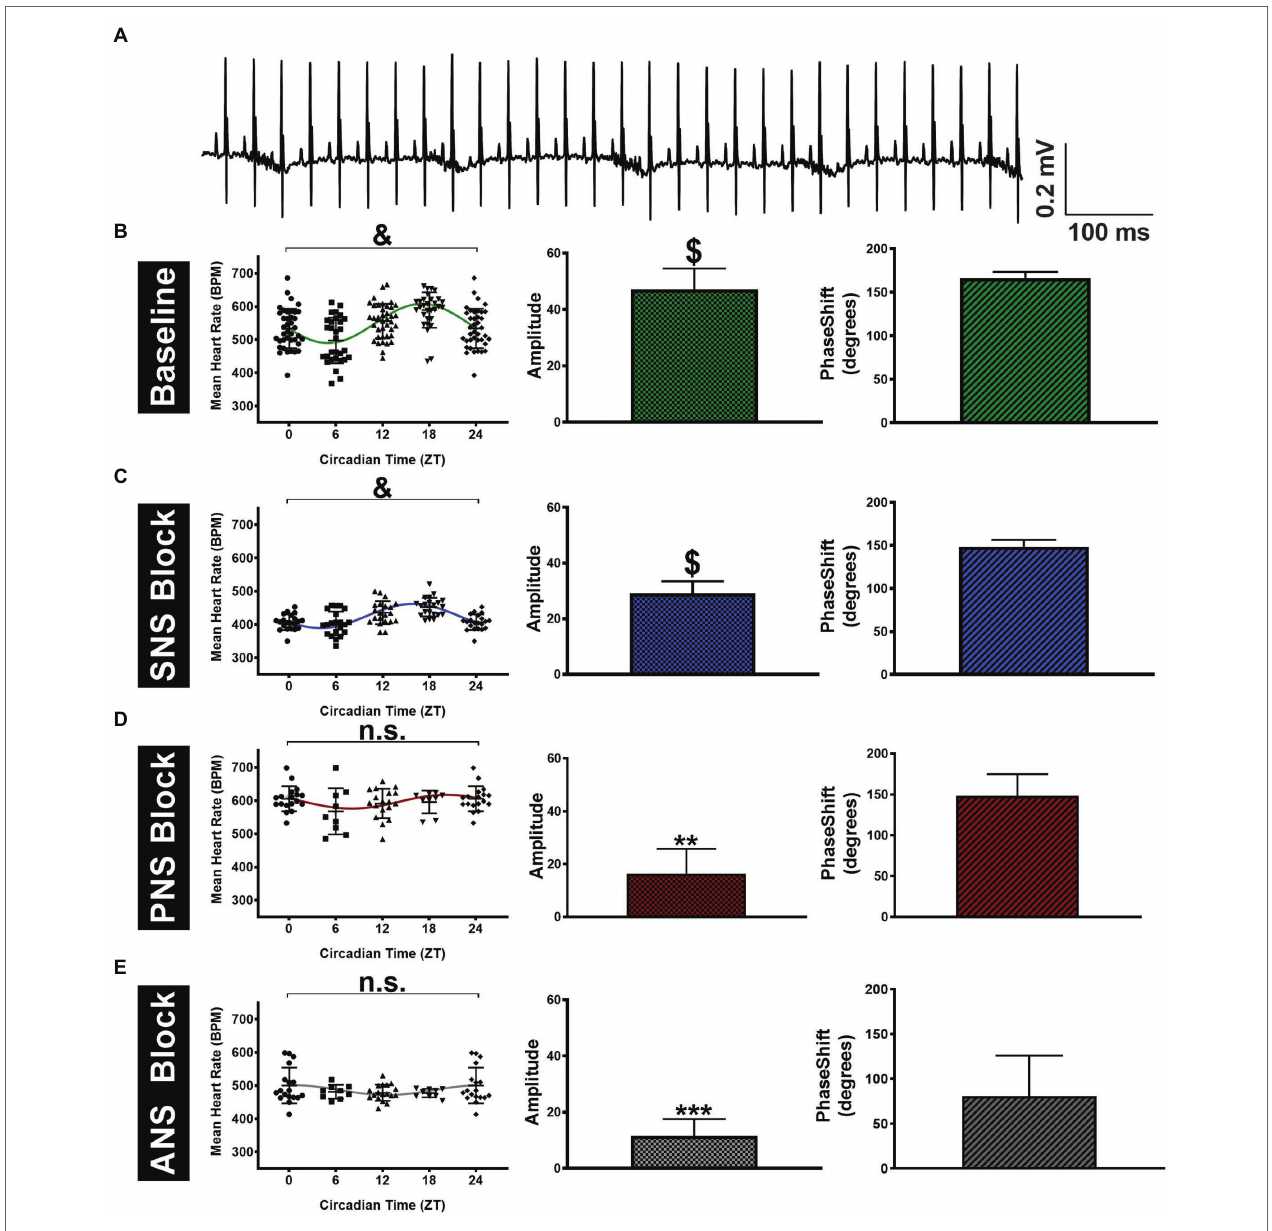
FIGURE 1 | Variation in surface ECG recorded mean HR of anesthetized mice throughout the day. (A) Sample telemetry ECG tracing recorded at ZT 12 at a sampling rate of 5 kHz. (B) The left panel shows the estimated HRs across four time points (ZT0 data are the same as ZT24) for mice ( n = 13) under baseline conditions. The green line represents the sine function that yields the best nonlinear fit to the HR data shown. The non-zero ( p < 0.0001) amplitudes (middle panel) and the accompanying phase shifts (right panel) estimated from the best fits are shown. (C) Results are shown after SNA blockade with propranolol (10 mg/kg i.p.) with significant ( p < 0.0001) fluctuations in HR throughout the circadian day (left panel) accompanied by non-zero amplitudes in HR fluctuations (middle panel, p < 0.0001). (D) HR data after PNA blockade with atropine (2 mg/kg i.p.) showed no significant fluctuations in HR (left panel, p = 0.24) accompanied by non-zero amplitudes in HR fluctuations (middle panel, p = 0.002). (E) HR data under total autonomic blockade with atropine + propranolol showing insignificant fluctuations in HR ( left panel , p = 0.31) contrasted by non-zero amplitudes in HR fluctuations ( middle panel , p = 0.0007). Data are presented as Mean ± S.D. & p < 0.0001 and n.s ( p = 0.24 for D and p = 0.31 for E ) using a mixed-model repeated measures ANOVA (left panel) . ** p < 0.01, *** p < 0.001, and $ p < 0.0001 based on the zero amplitude (no rhythm) test from nonlinear fits (middle panel)